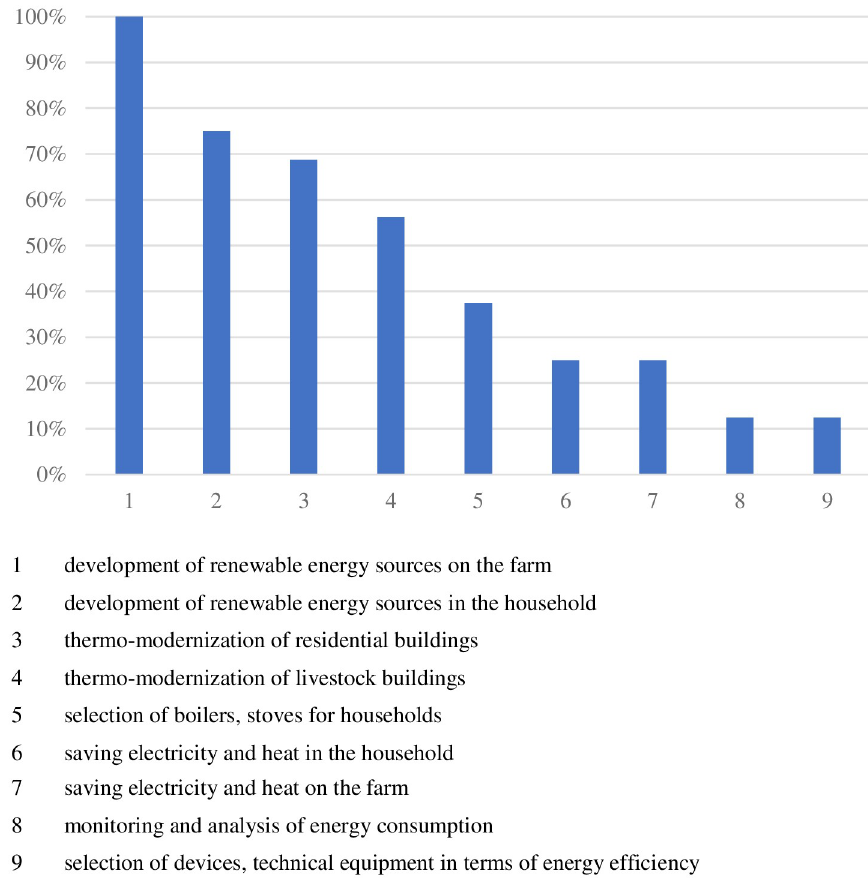
Fig 4. The most frequent topics of training in effective management of electricity and heat in the household of farmers/farm. Source: Own study based on questionnaire surveys (N = 16).